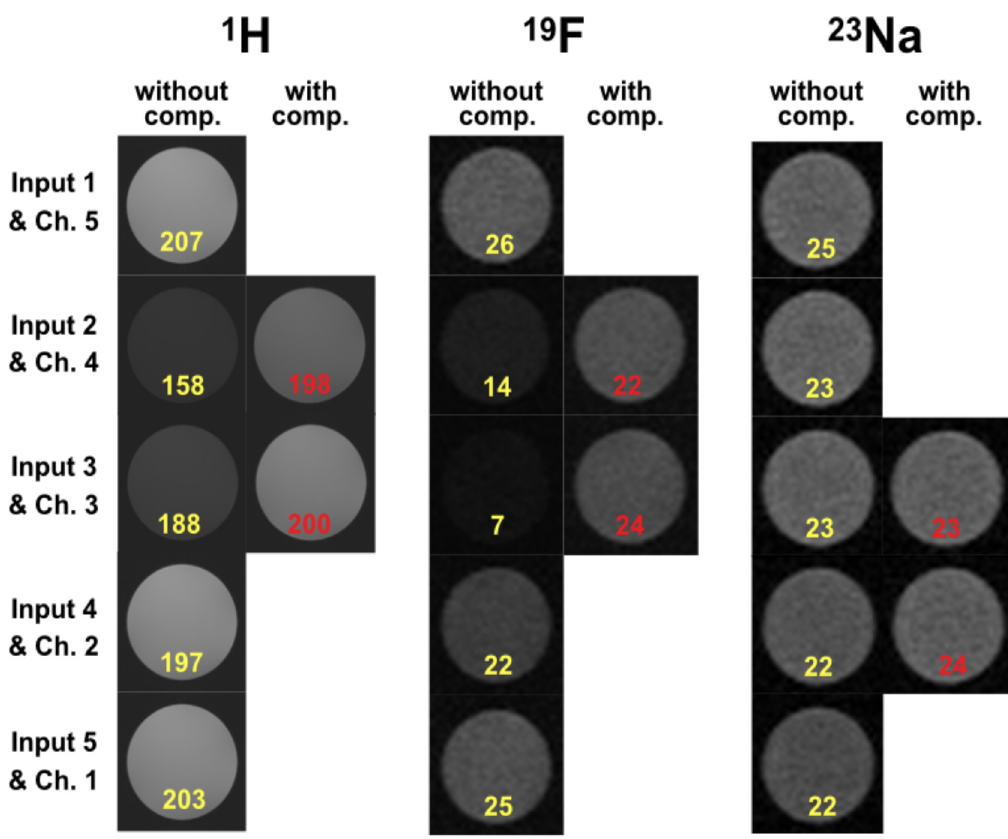
Fig 4. Measured FLASH images for different nuclei when the prototype switch matrix is present in the 9.4 T animal MR system. The yellow text gives SNR values when leaving transmission lines uncompensated, the red text shows compensated (91 pF) transmission line